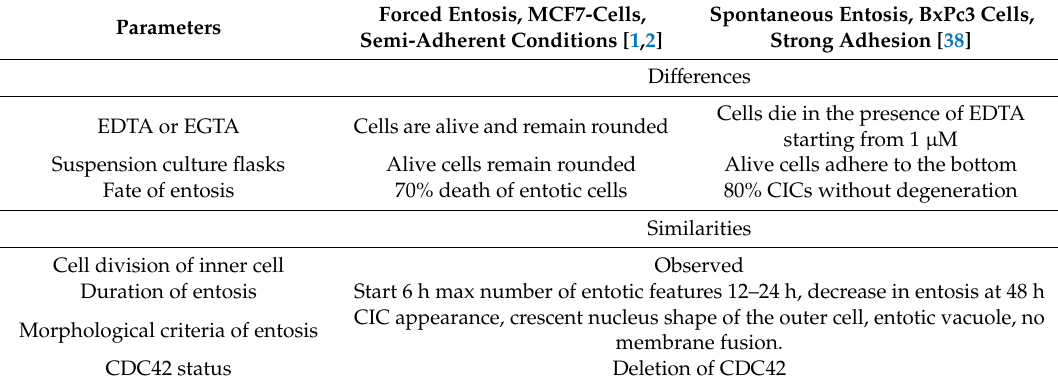
Table 2. Di ff erences and similarities in entosis between MCF7 and BxPc3 cells. Forced Entosis, MCF7-Cells, Spontaneous Entosis, BxPc3 Cells, Parameters Semi-Adherent Conditions [1,2] Strong Adhesion [38] Di ff erences Cells die in the presence of EDTA EDTA or EGTA Cells are alive and remain rounded starting from 1 µ M Suspension culture flasks Alive cells remain rounded Alive cells adhere to the bottom Fate of entosis 70% death of entotic cells 80% CICs without degeneration Similarities Cell division of inner cell Observed Duration of entosis Start 6 h max number of entotic features 12–24 h, decrease in entosis at 48 h CIC appearance, crescent nucleus shape of the outer cell, entotic vacuole, no Morphological criteria of entosis membrane fusion. CDC42 status Deletion of